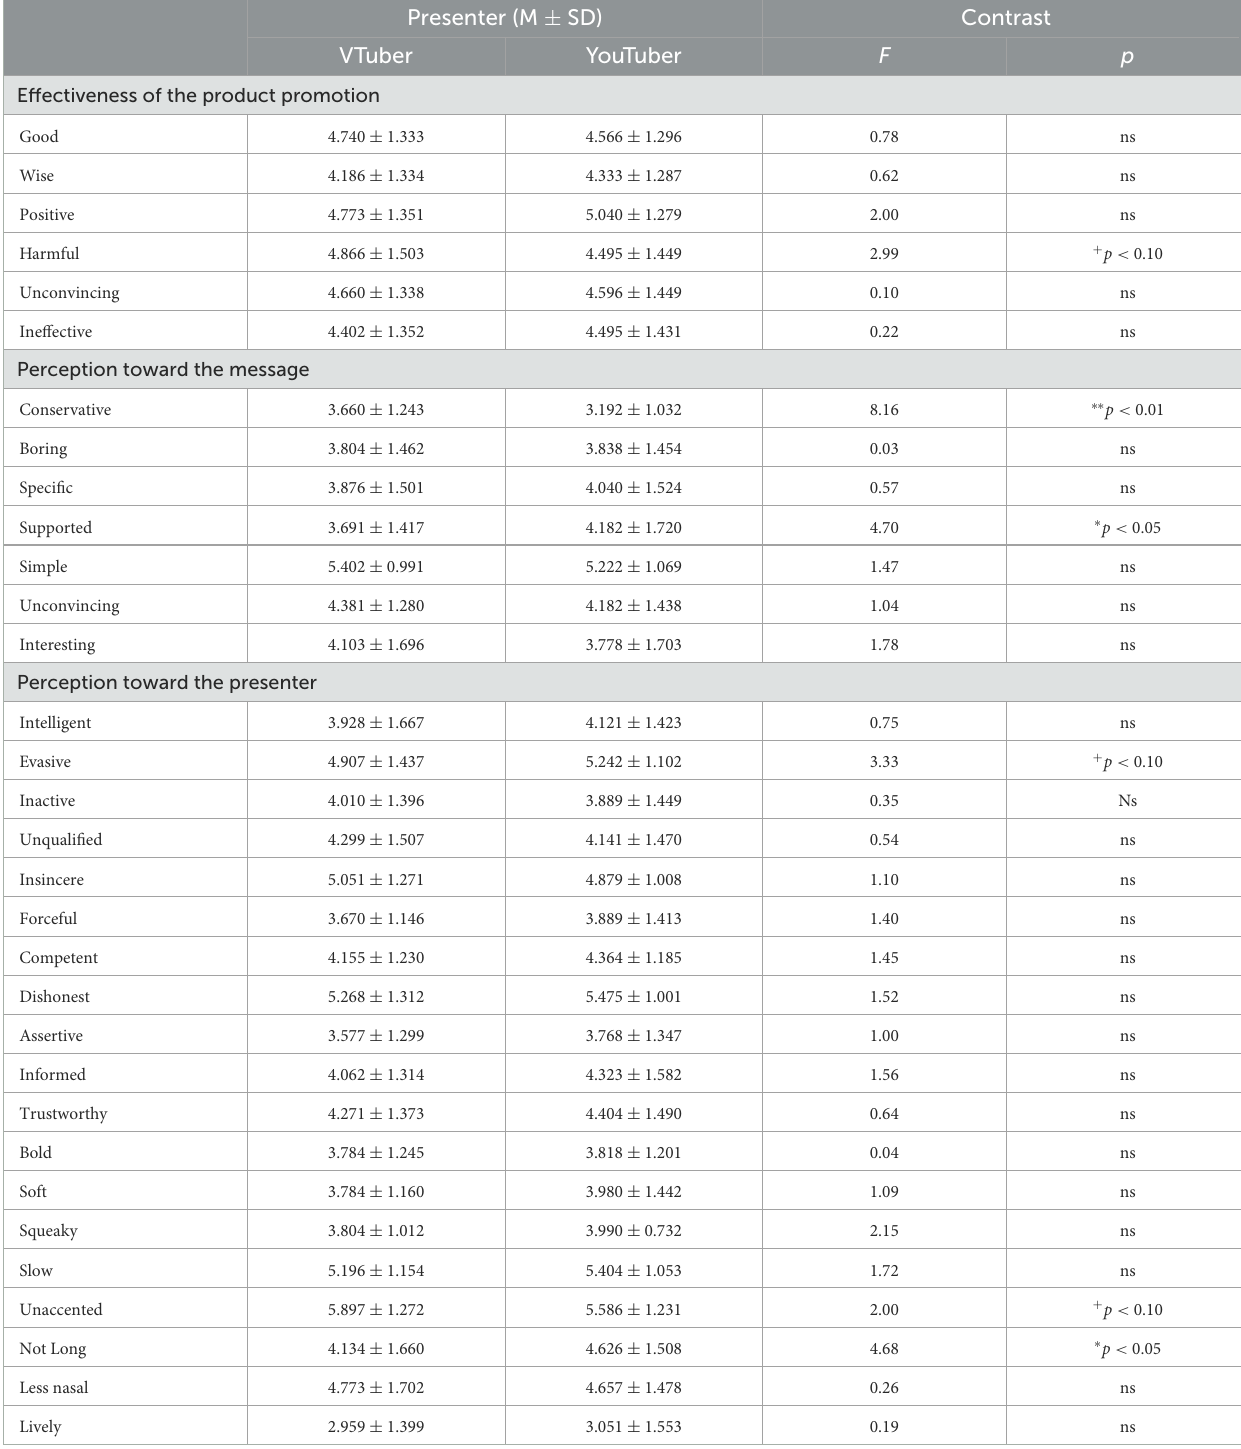
TABLE 2 Data from the persuasiveness rating